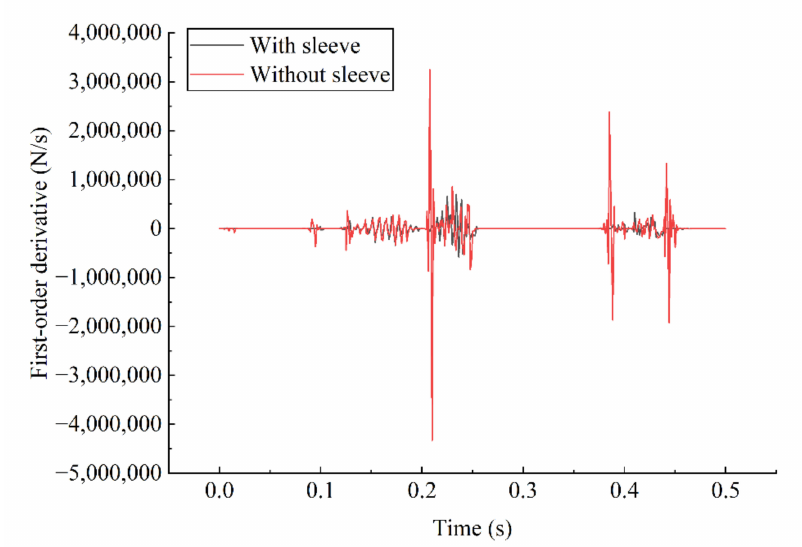
Figure 18. First-order derivative of the meshing force